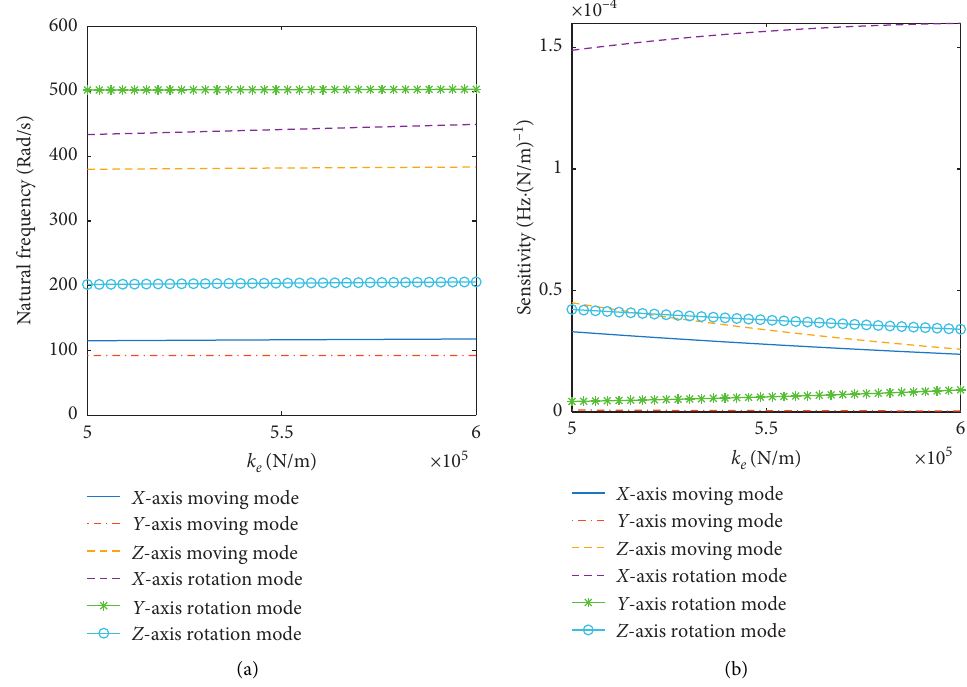
Figure 13: Curve of variation of natural frequency and its sensitivity with stiffness of outer leg 5. (a) Natural frequency. (b) Sensitivity of natural frequency to the stiffness of outer leg